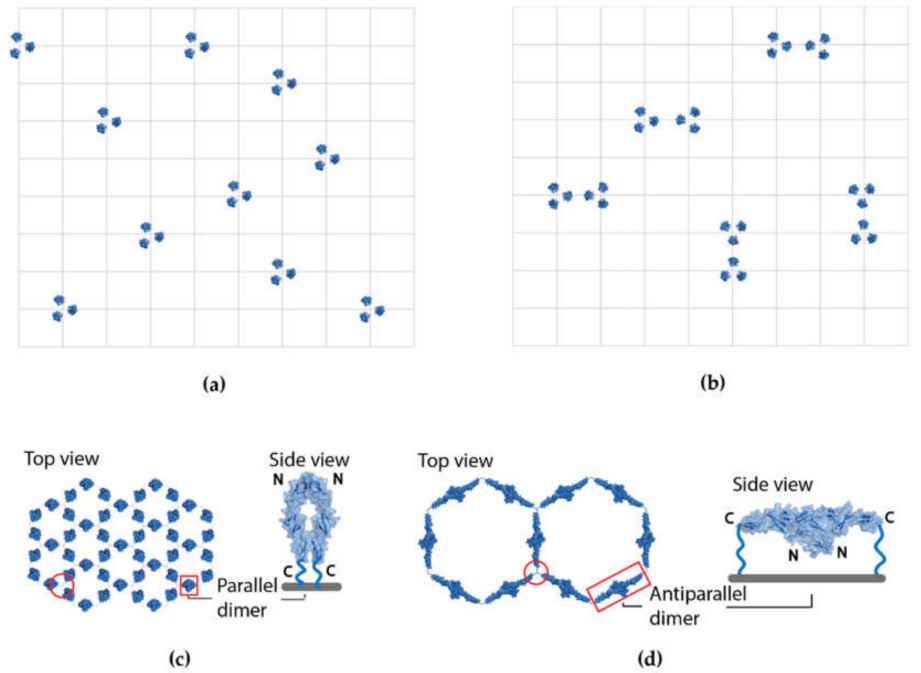
Figure 1. Representative arrangements of receptors on the cell surface. ( a ) An example of a random arrangement of 10 receptor trimers limited to lattice points of a 10 × 10 matrix, top view. Even with this constraint there are more than 17 trillion possible combinations (C(100,10)), more than 4 trillion of them unique. To activate these receptors with their corresponding membrane-bound ligands, the ligands would have to be arranged exactly the same way to simultaneously activate the receptors. The probability of that is less than 1 in 4 trillion. ( b ) Random arrangement of pairs of receptor trimers. Having 10 receptors arranged in pairs of trimers on the cell surface lowers the number of unique receptor arrangements to over 38 million and the probability that one of these arrangements will match up with corresponding random ligands is still very low. ( c ) Tight hexagonal lattice with parallel dimer arrangements of TNF receptor 1 (TNFR1) [Protein Data Bank (PDB) ID:1NCF] top view, and side view of a single dimer. The N and C terminal are labeled. ( d ) Hexagonal lattice with antiparallel receptor dimers of TNFR1 (PDB ID: 1NCF) top view, and side view of a single antiparallel dimer. Five times as many receptors can be fit into the same area in the tight hexagonal cluster in ( c ) compared to the larger hexagonal lattice occupied by the antiparallel receptor dimers. The red circles in ( c ) and ( d ) illustrate the trimerization interface. The molecular representations were created by the molecular graphics program PyMOL